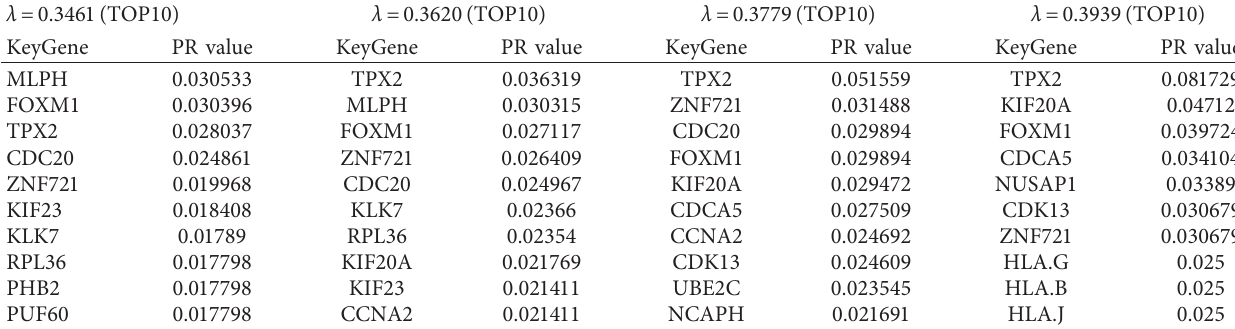
Table 3: TOP gene and PR values with different thresholds under the PageRank algorithm. λ � 0.3461 (TOP10)